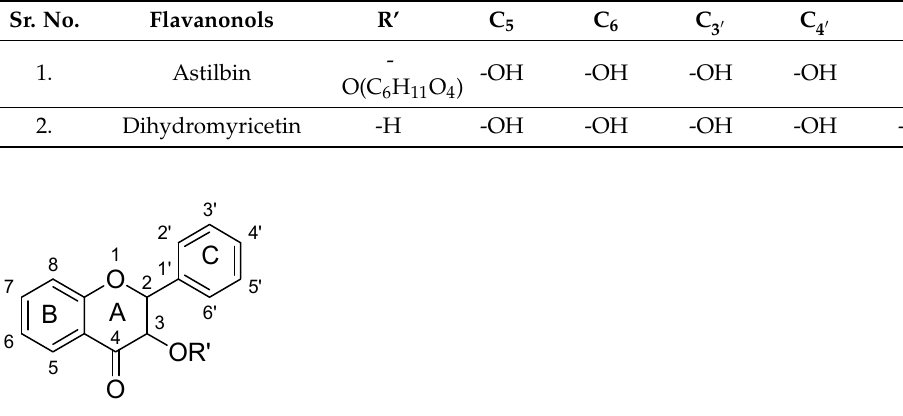
Figure 38. Skeleton of Flavanonols.